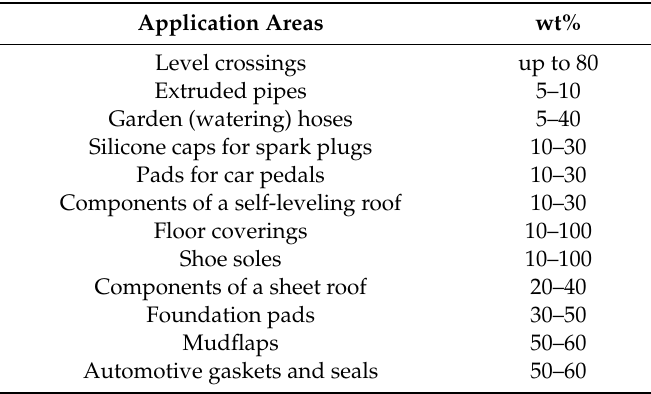
Table 3. Crumb rubber uses in technical